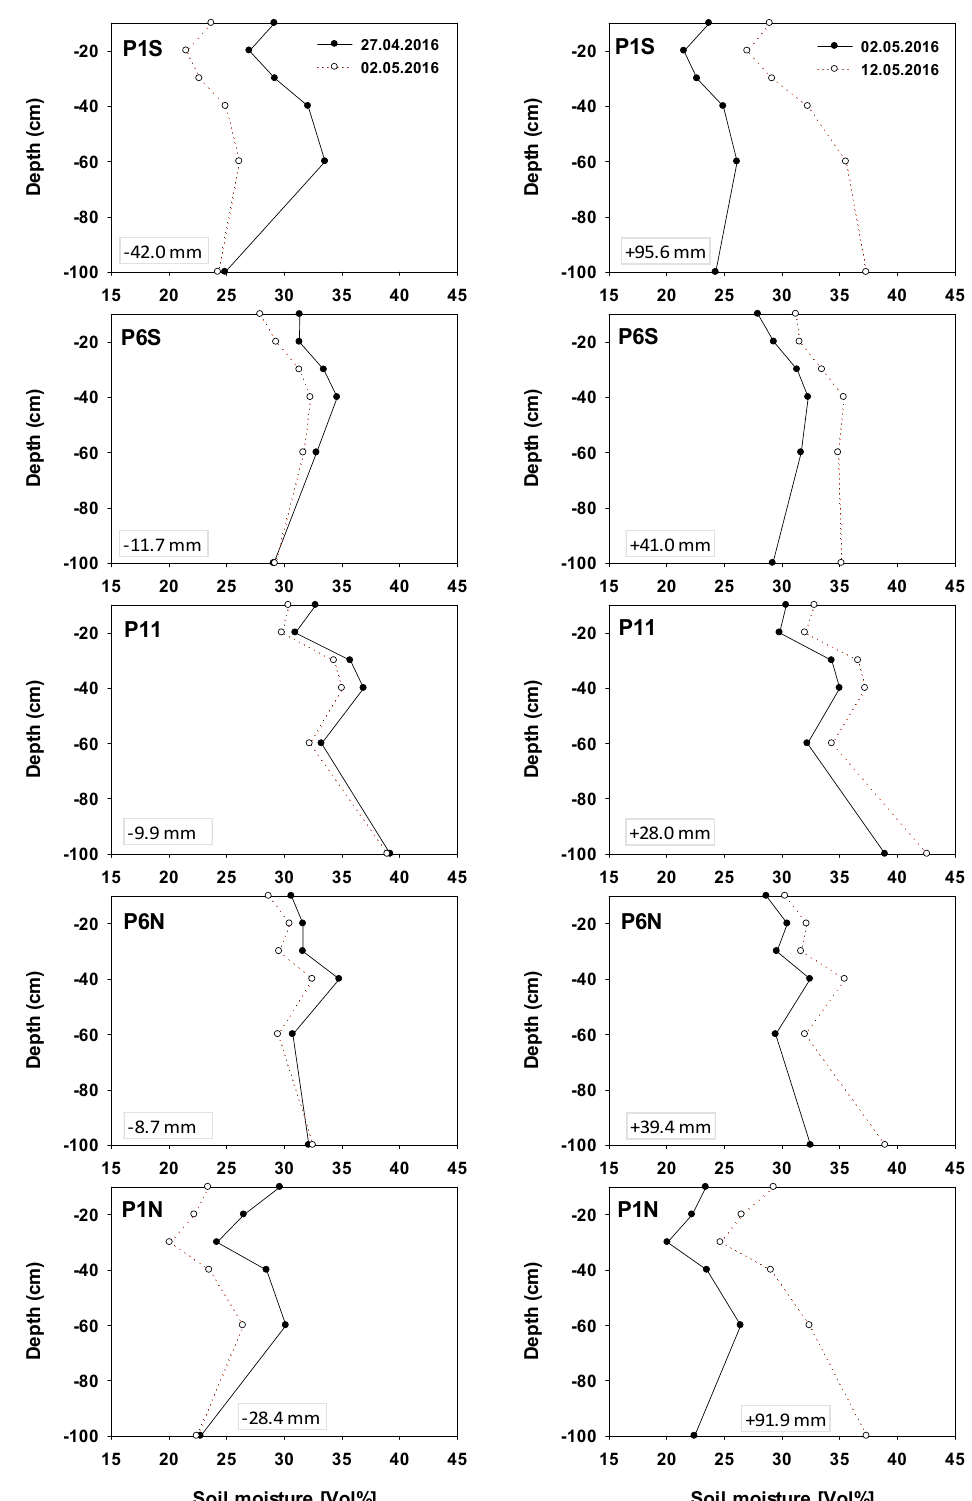
Figure 7. Soil moisture (Vol%) at different depth for each sample points between the tree rows. Sample points between the tree rows are P1S: 1 m and P6S: 6 m from southern row. P1N: 1 m and P6N: 6 m from northern row. P11: 11 m from southern and northern row, respectively. The left panel shows soil moisture change during a dry period between 27 April 2016 and 2 May 2016, when in total less than 1 mm of precipitation was recorded. In contrast to the right panel that shows, the subsequent rewetting period until 12 May 2016, when in total 123 mm of precipitation was recorded. Inserted numbers in each graph show the cumulative change in soil moisture over 0–100 cm.